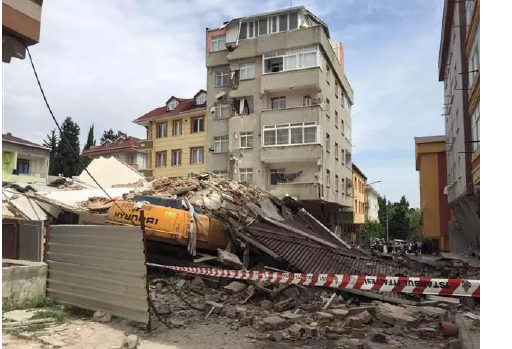
Figure 7. The collapsed building (Web-3)